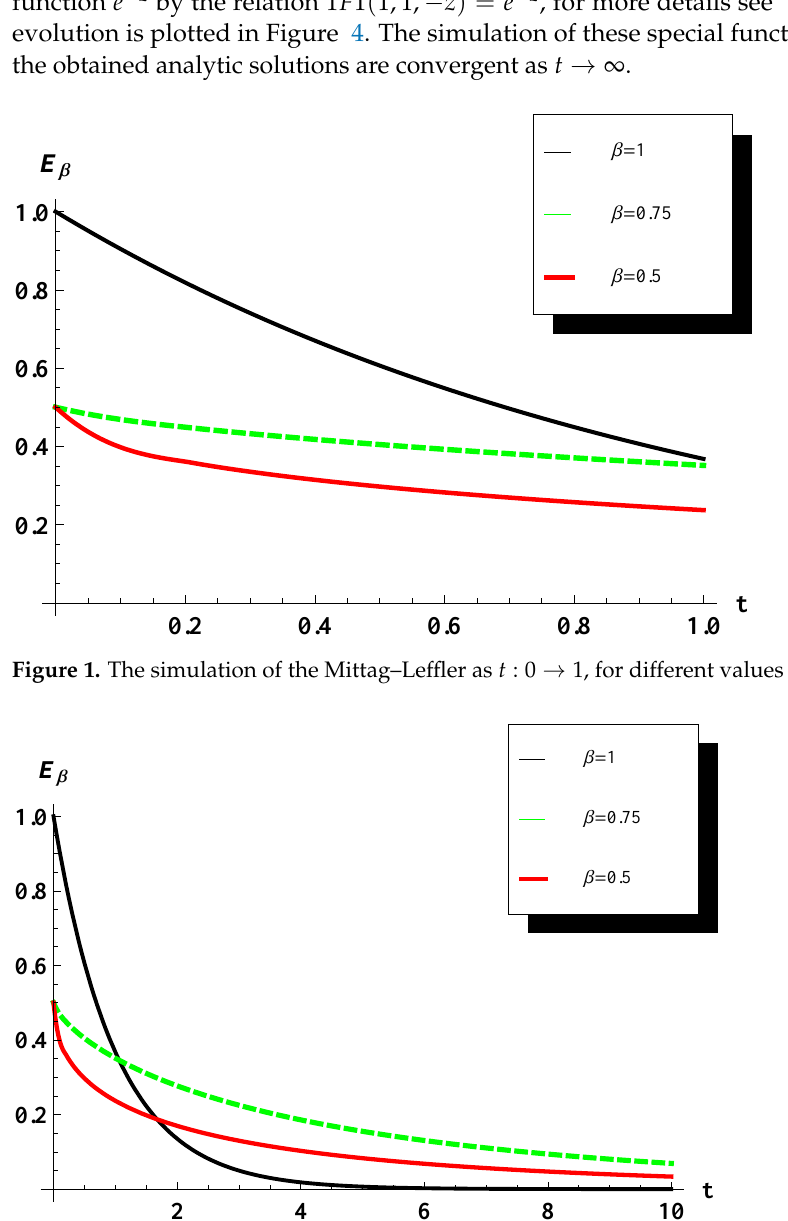
Figure 2. The simulation of the Mittag–Leffler as t : 0 → 10, for different values of β